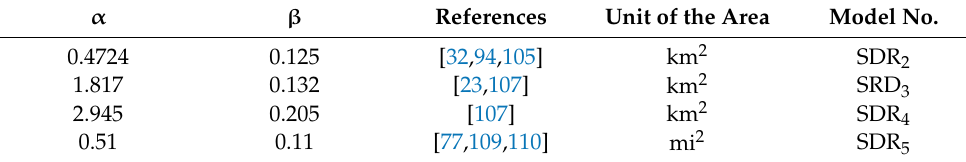
Table 7. The α and β coefficients used to estimate the SDR in the